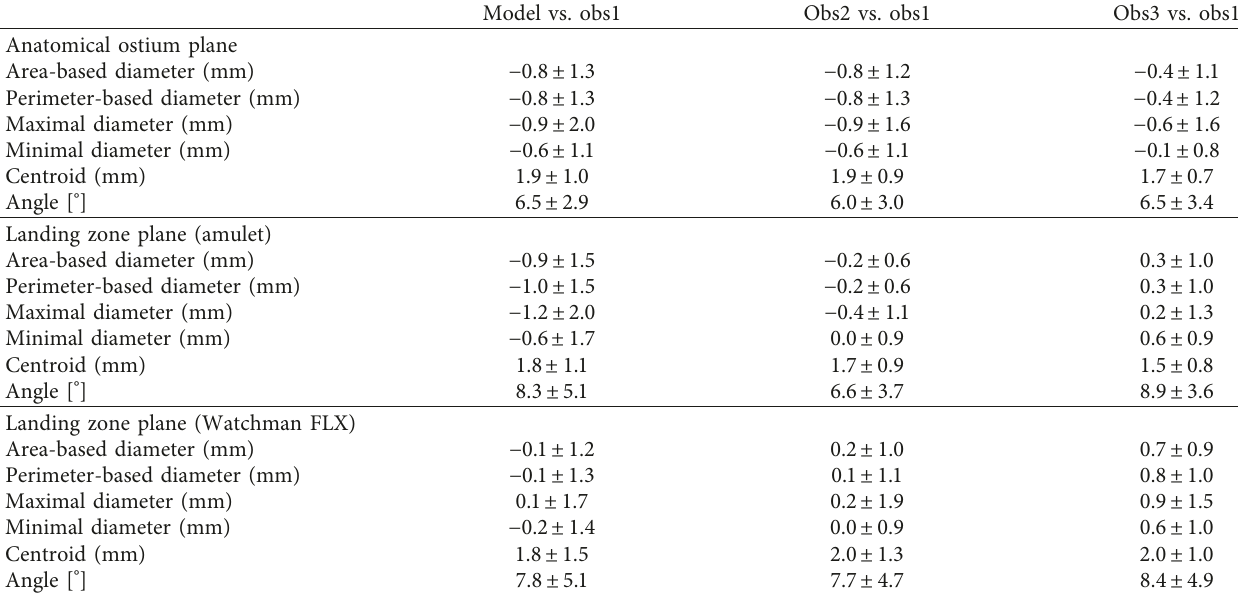
Table 1: Overview of the differences between the manual analysis from observer 1 (obs1), the model predictions, and the manual analyses of observer 2 (obs2) and 3 (obs3). The differences are reported as mean ± standard